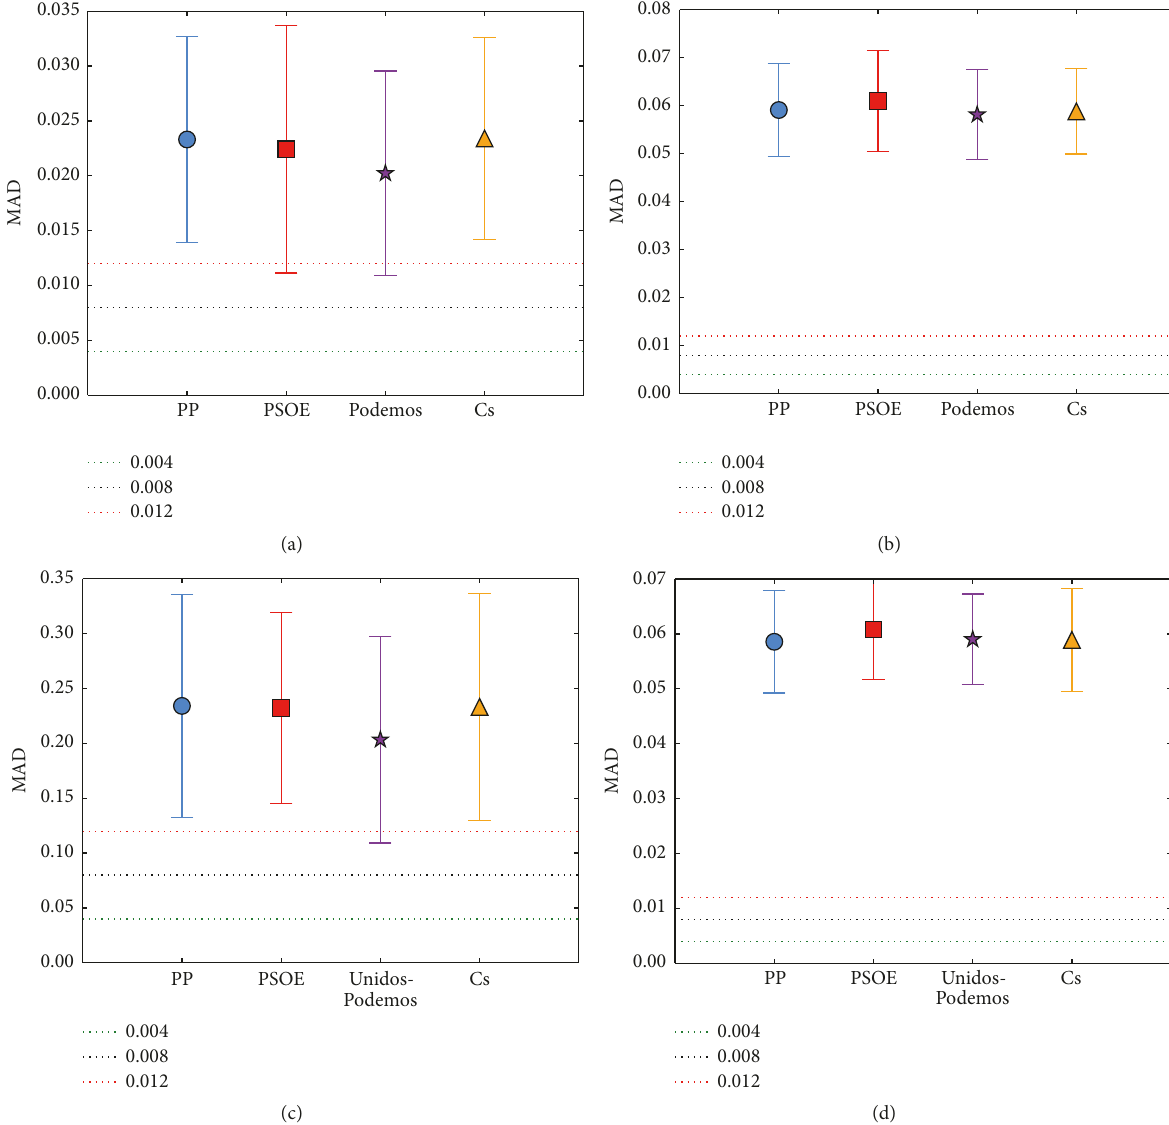
Figure 11: Summary of MAD goodness of fit to 1BL (a, c) and 2BL (b, d) for 2015 (a, b) and 2016 (c, d), performed individually at each precinct (each precinct shows a precise distribution and an associated MAD, so here we plot the mean ± standard deviation over all Spanish precincts, excluding Ceuta and Melilla, precincts with a single municipality). In every case, the critical values for rejection at the 95 and 99% confidence level are shown. Interestingly, in the case of 1BL for a large majority, we accept conformance to Benford’s law, whereas, in the case of 2BL for a large majority, the null hypothesis is rejected. All these results are consistent with the hypothesis test based on